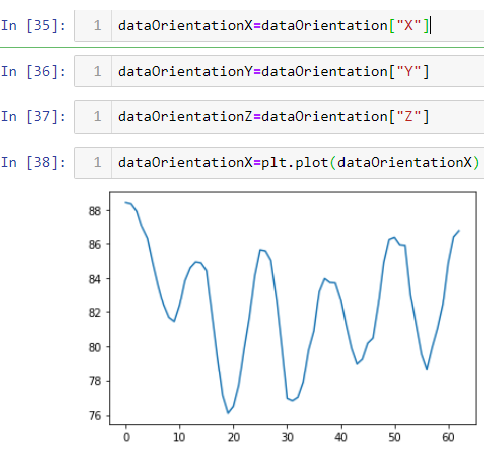
Figure 52. Data fluctuating between 78 and 86 at one fixed point. dataOrientationY=dataOrientation[“Y”] and dataOrientationY=plt.plot(dataOrientationY) were used similarly, in order to plot the y -axis data. We can observe that noisy data were obtained. Orientation can be measured as 180 degrees on the positive side when starting from the north direction, turning right towards the south direction. Meanwhile, a negative